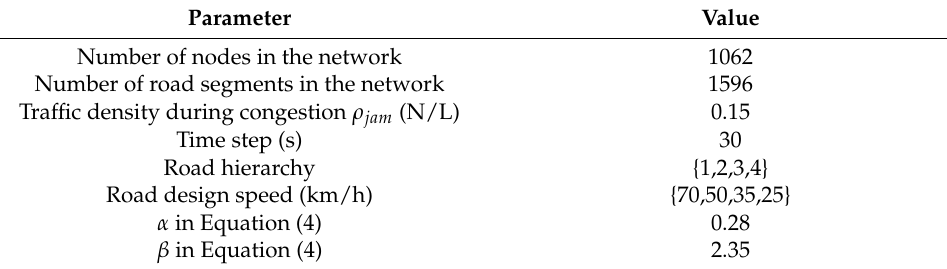
Figure 9. Administrative divisions of Wuhan City, China, and the selected study area. Table 3. Parameter settings of the actual case